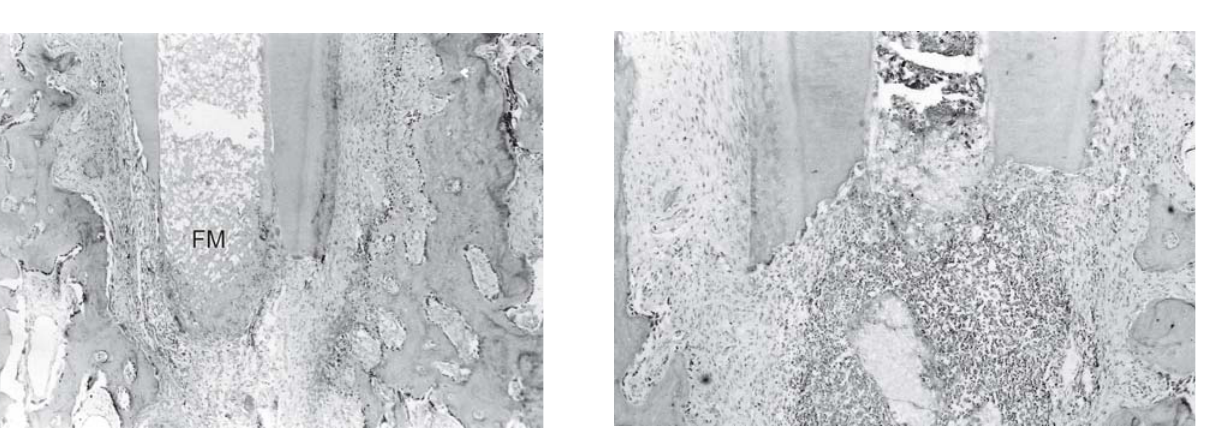
FIGURE 1 - Maisto paste. There is more resorption of the apical third of the root than of the filling material (FM). H.E.